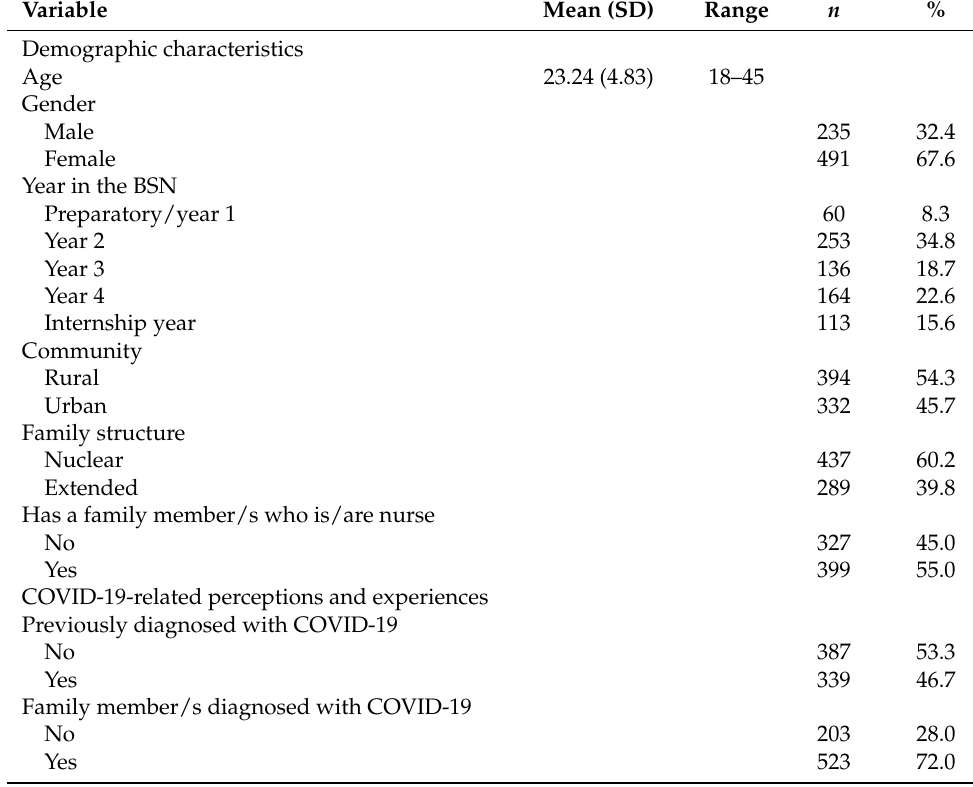
Table 1. Demographic and COVID-19-related perceptions and experiences of the participants ( n =